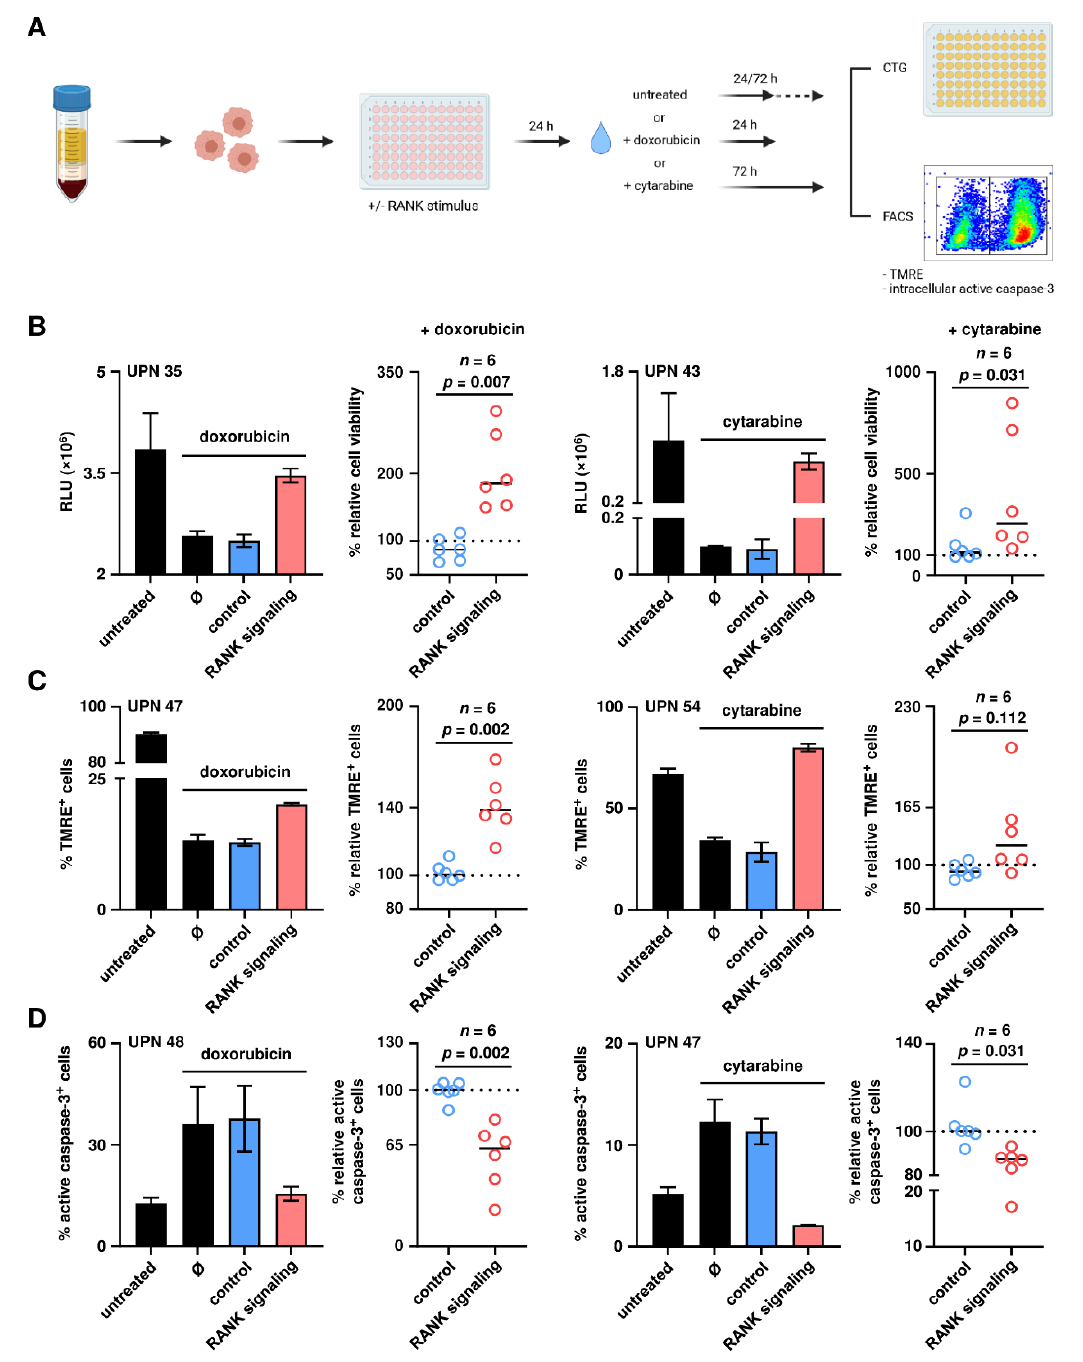
Figure 3. Resistance of primary AML cells to chemotherapeutic agents upon RANK signaling. ( A ) Schematic workflow for the analysis of resistance to doxorubicin and cytarabine of primary AML cells upon stimulation of RANK. ( B ) Cell viability was determined by CTG assay. Results of one representative experiment (bars) and combined results obtained in independent experiments with leukemic cells of n = 6 AML patients are shown (dot plots; solid lines, median; dotted lines, 100% relative cell viability; Ø, samples only treated with the respective chemotherapeutic agent). For combined results, data were normalized to samples treated with the respective chemotherapeutic agent (Supplementary Figure S2) and relative cell viability was calculated. ( C ) Mitochondrial membrane potential of AML cells was analyzed by staining with TMRE using flow cytometry. Results of one representative experiment (bars) and combined results obtained in independent experiments with leukemic cells of n = 6 AML patients are shown (dot plots; solid lines, median; dotted lines, 100% relative mitochondrial membrane potential; Ø, samples only treated with the respective chemotherapeutic agent). For combined results, data were normalized to samples treated with the respective chemotherapeutic agent (Supplementary Figure S2) and relative mitochondrial membrane potential was calculated. ( D ) Active caspase-3 in viable AML cells was